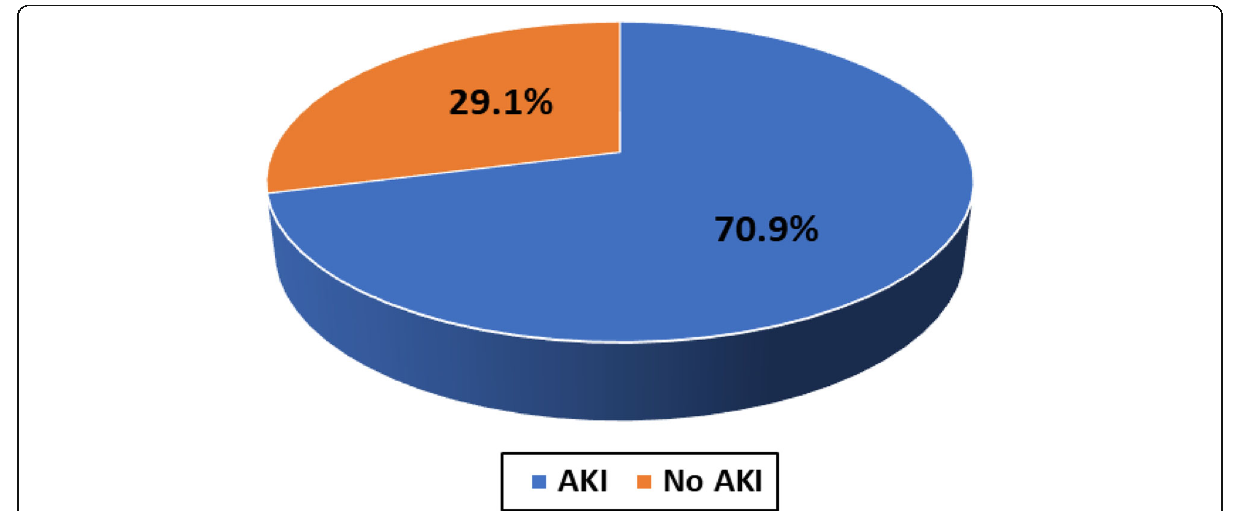
Fig. 1 Frequency of AKI among the studied COVID-19 patients